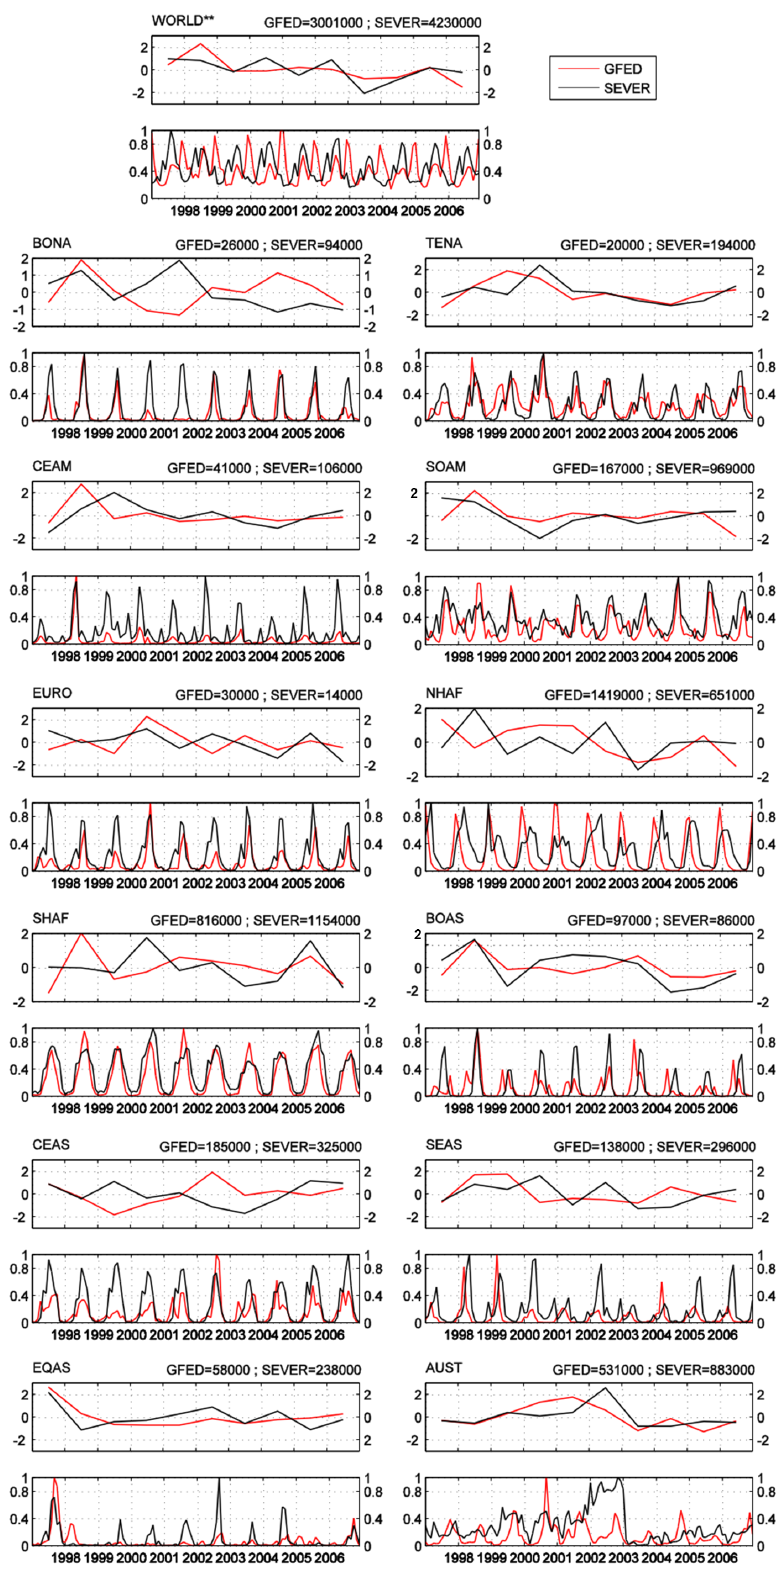
Figure 14. Regional comparison of fire variability over 1997–2006. For each region subplot the top shows annual anomalies and the bottom shows monthly time series constrained to [0, 1]. The region name is indicated at the top left corner and the average fire incidence at the top